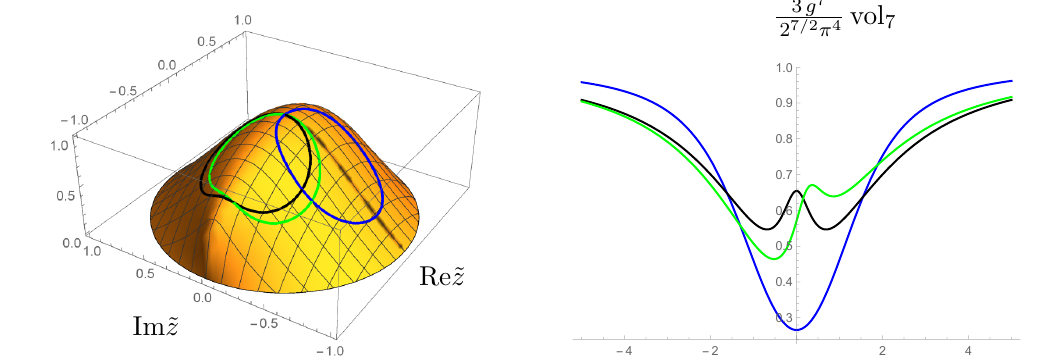
Figure 6 . Left: volume of the internal seven-sphere as a function of the complex scalar ˜ z (orange dome). Examples of regular Janus flows (loops) are superimposed. Right: volume of the internal seven-sphere as a function of the radial coordinate ρ for the regular Janus solutions. The parameters of the curves are: α = 1 and β = − π (blue line), β = π (black line) and β = 17 π (green line). 2 16 Note the presence of two minima (throats) in the black and green